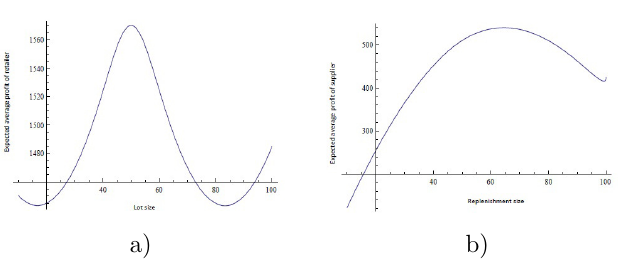
Figure 1. Expected average profits: a) π R of the retailer versus lot size ( Q ), b) π S of the supplier versus replenishment size ( R ).